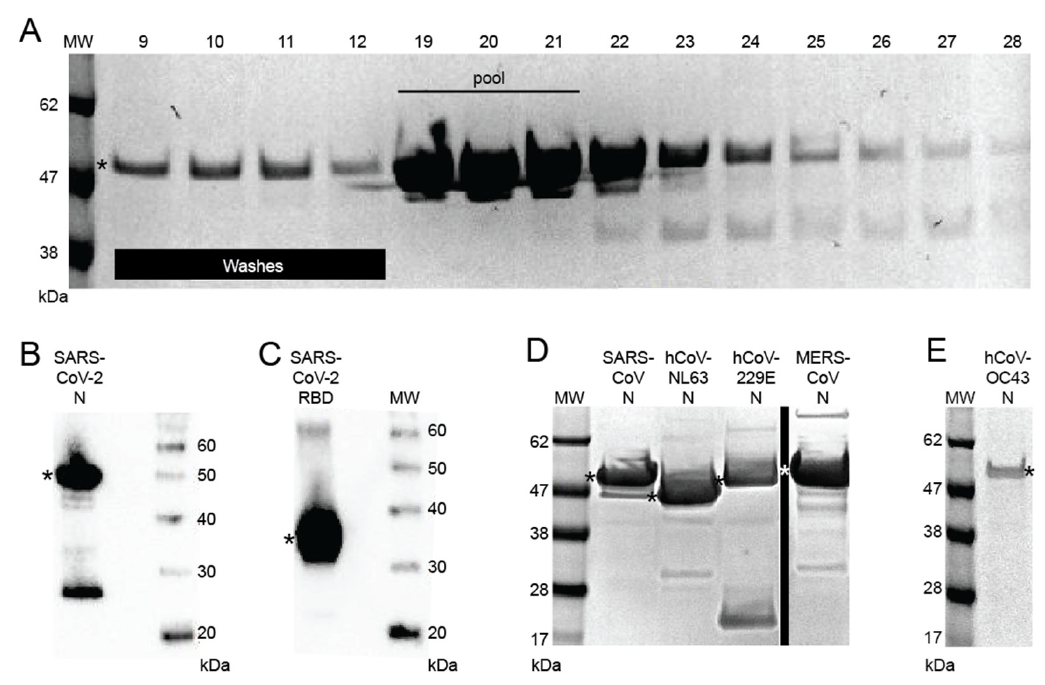
Figure 1. Recombinant coronavirus proteins. ( A ) Nucleoprotein (N) from SARS-CoV expressed in E. coli , purified, and proteins in selected fractions were resolved by sodium dodecyl-sulfate polyacrylamide gel electrophoresis (SDS-PAGE). ( B ) SARS-CoV-2 nucleoprotein was expressed in E. coli , purified, and resolved by SDS-PAGE as described for SARS-CoV. Monomeric forms of the protein (asterisks) and a breakdown product were detected. ( C ) SARS-CoV-2 receptor binding domain was expressed in Expi293 cells, purified, and resolved by SDS-PAGE for ( D ) SARS-CoV N, hCoV-NL63 N, hCoV- 229E N, MERS-CoV, and ( E ) hCoV-OC43 N. Vertical lines indicate removal of lanes from a gel. Asterisk (*): monomeric N or RBD. Uncropped polyacrylamide gel D is shown in Figure S1.